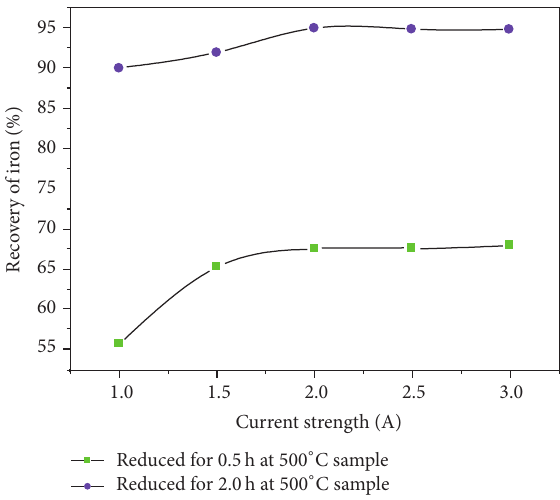
Figure 16: Dependence of the concentrate grade on the conversion of Fe 2 O 3 .